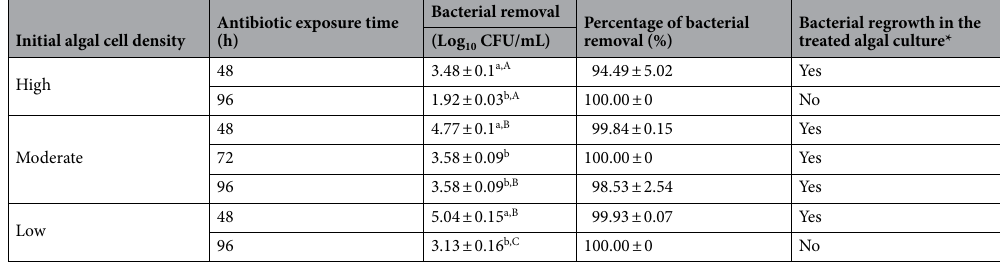
Table 1. Bacterial removal in the algal cultures with different initial algal cell densities and antibiotic exposure times in the basic protocol. Initial algal cell counts: High, 3.5 × 10 5 , Moderate, 1 × 10 5 and Low, 3.5 × 10 4 cells. Data of bacterial removal and percentage of bacterial removal are presented as means ± standard deviations of three independent experiments (n = 3). *Samples were taken and monitored at days 1, 3, and 7 of the algal cultures. Different small and capital letters indicate that means were significantly different among antibiotics exposure times (a and b) and initial algal cell densities (A and B), respectively at p ≤ 0.05 according to one-way analysis of variance followed by Tukey multiple comparison